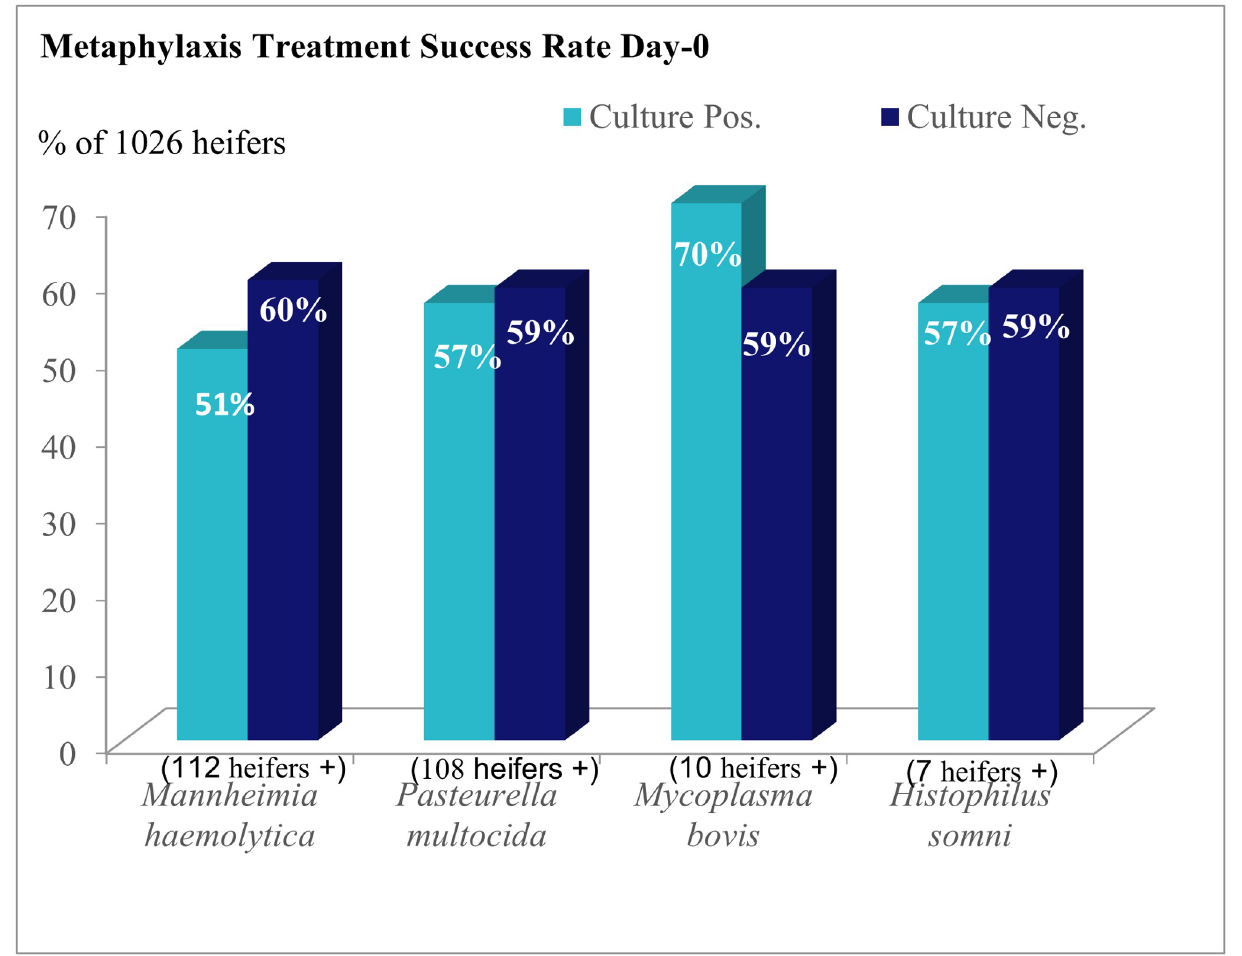
Fig 3. Metaphylaxis treatment success rate by culture of bacterial pathogen via nasopharyngeal swab at day-0.